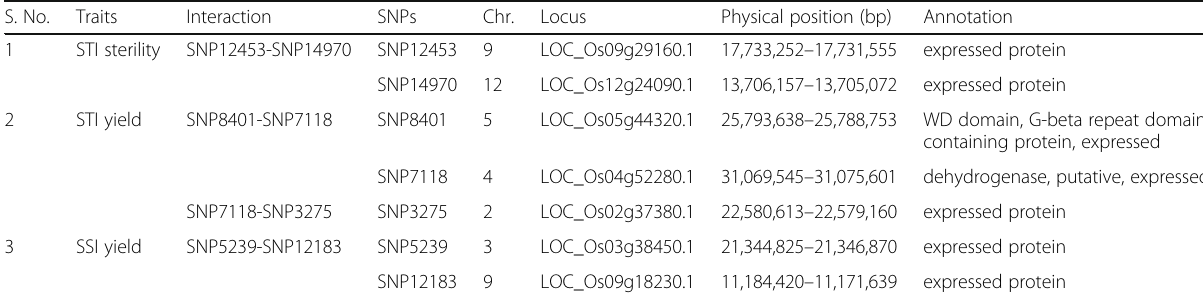
Table 5 Epistatic interaction network S.